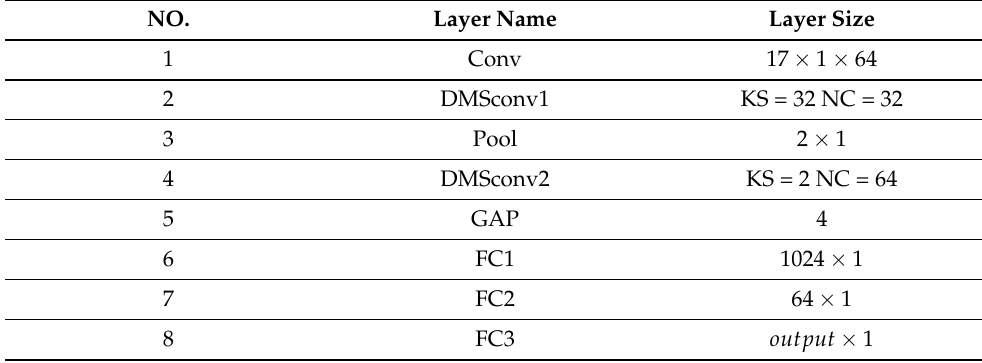
Table 2. Architecture-related hyperparameters of IMSCNN.